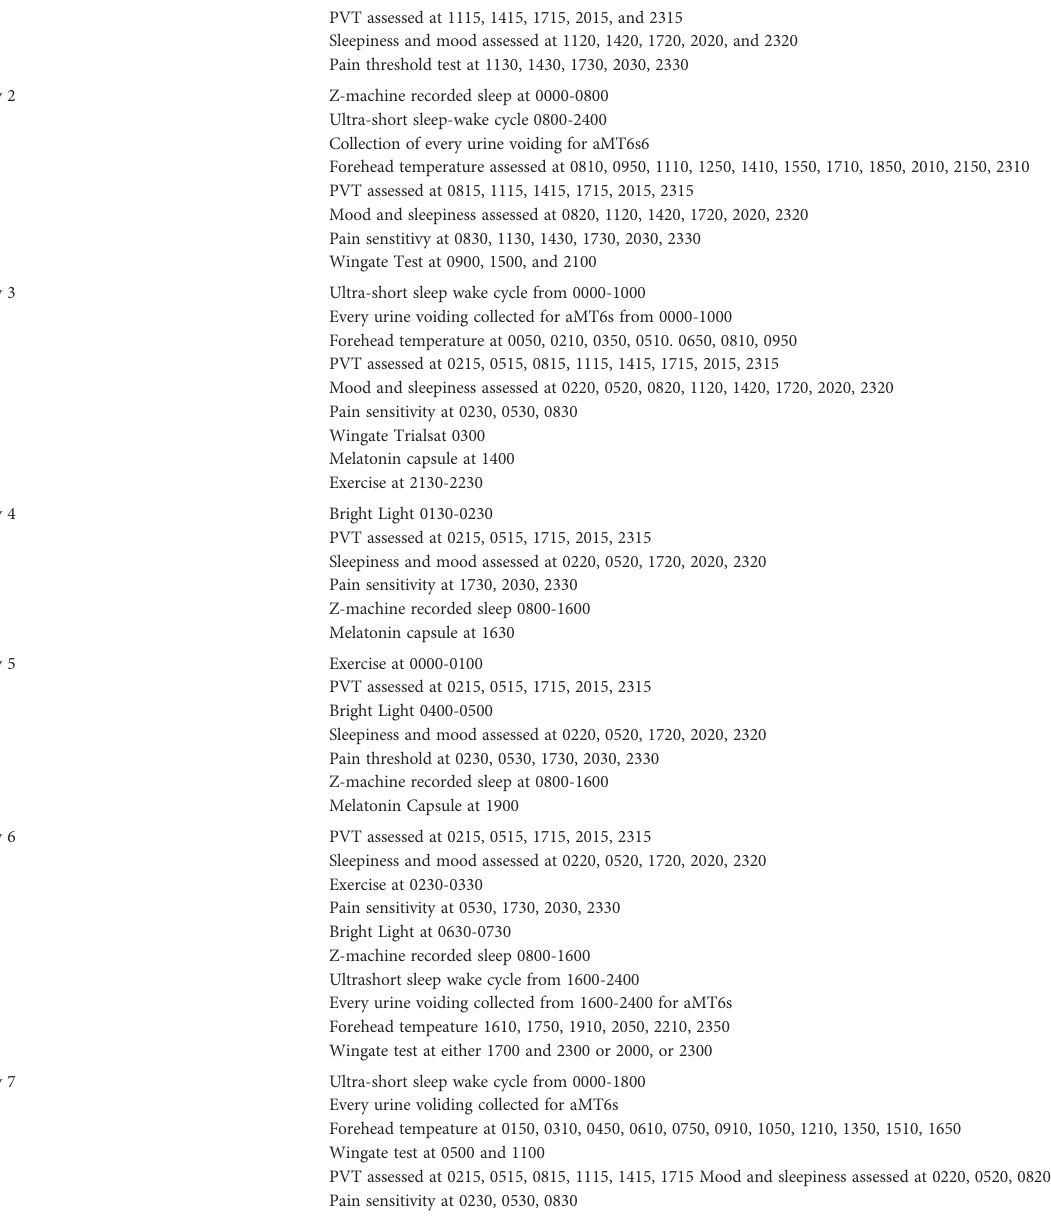
TABLE 1 Experimental